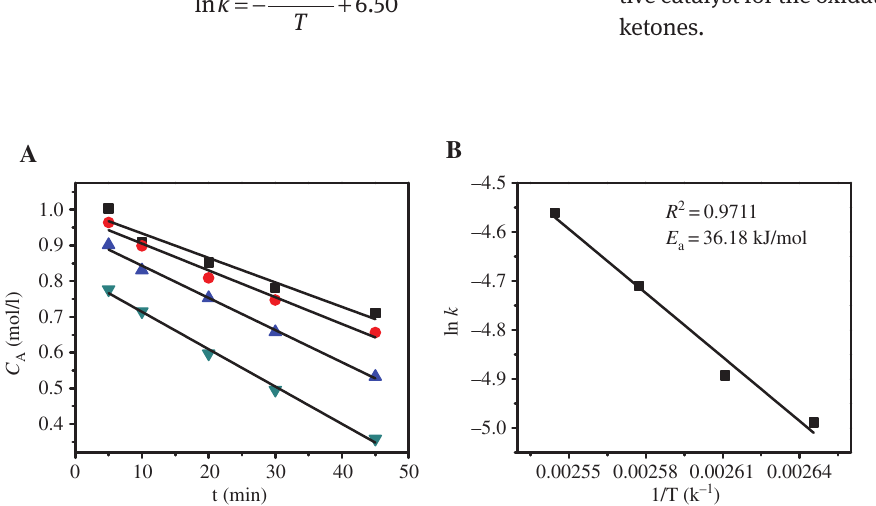
Figure 6: (A) Variations of BzOH concentration versus reaction time under different reaction temperatures: 378 K (■), 383 K (●), 388 K ( ▲ ), and 393 K ( ▼ ), and (B) the corresponding Arrhenius plot; reaction conditions: initial BzOH concentration 1.28 mol/l; H